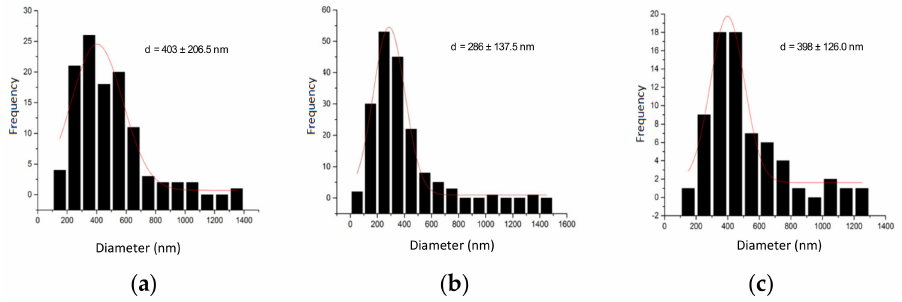
Figure 3. SEM size distribution analysis of ( a ) F1, ( b ) F2, and ( c ) F3.